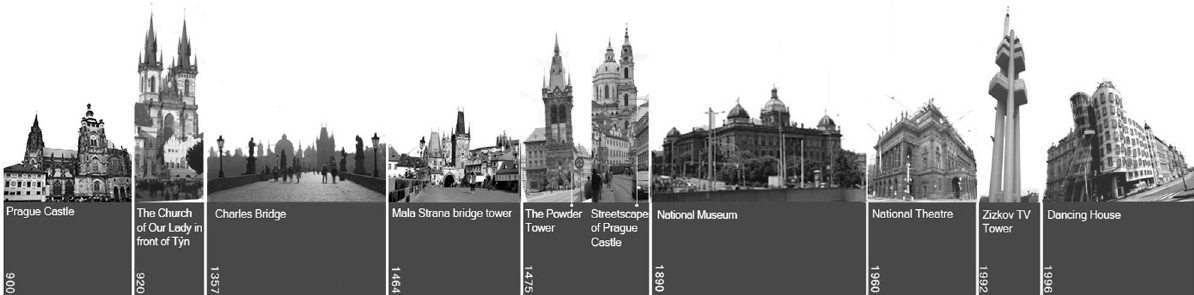
Fig. 13 The evolution of Prague architectural form.